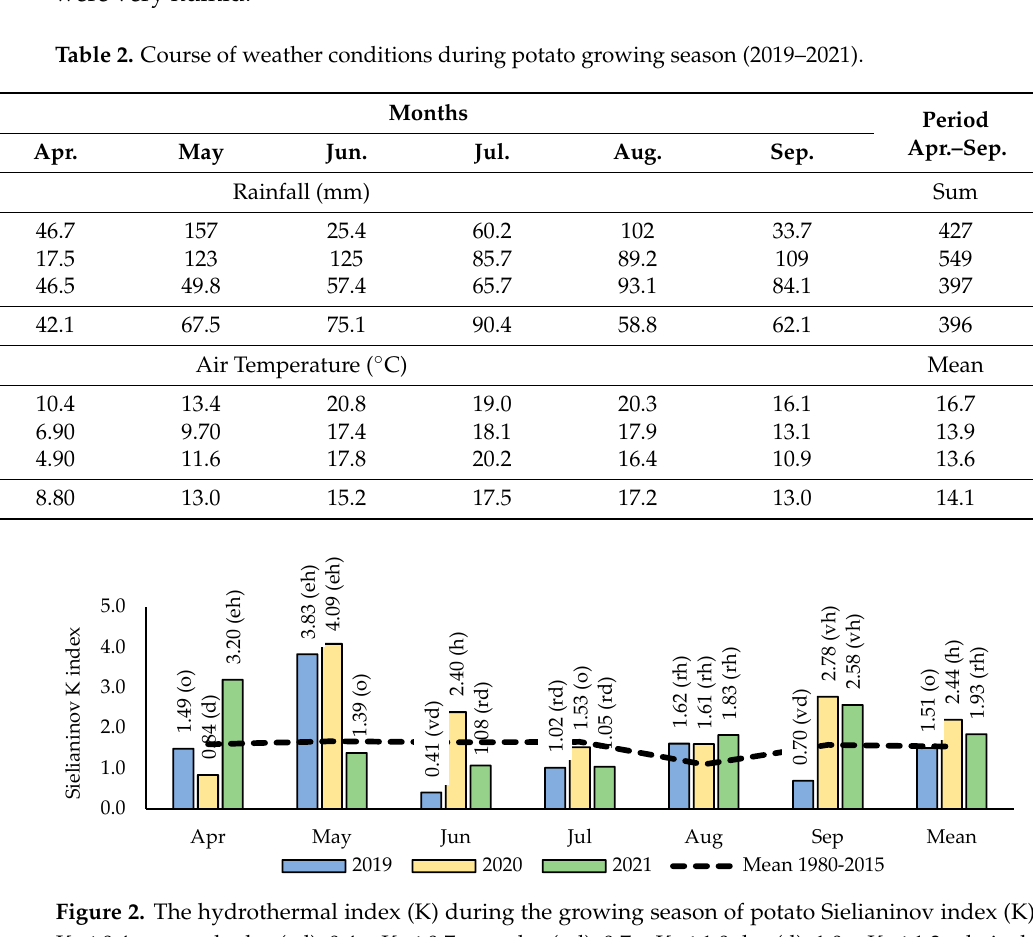
Figure 2. The hydrothermal index (K) during the growing season of potato Sielianinov index (K): K ≤ 0.4 extremely dry (ed), 0.4 < K ≤ 0.7 very dry (vd), 0.7 < K ≤ 1.0 dry (d), 1.0 < K ≤ 1.3 relatively dry (rd), 1.3 < K ≤ 1.6 optimal (o), 1.6 < K ≤ 2.0 relatively humid (rh), 2.0 < K ≤ 2.5 humid (h), 2.5 < K ≤ 3.0 very humid (vh), and K > 3.0 extremely humid (eh).